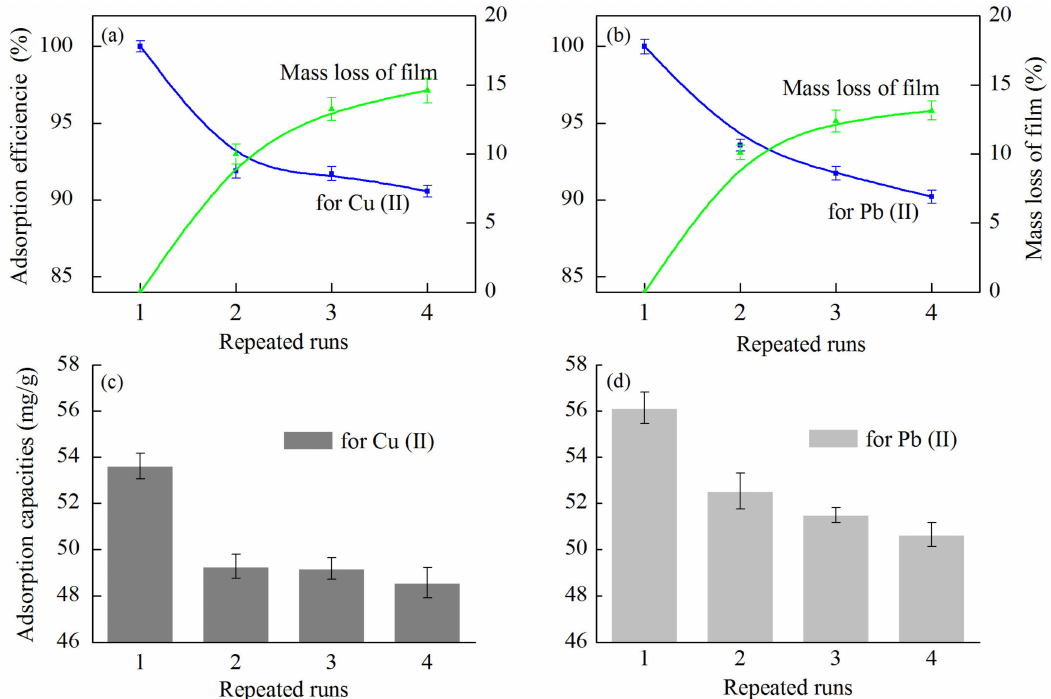
Figure 10. The adsorption efficiency and the stability of the CNC/CS/PVA-SH nanofibrous films for ( a ) Cu(II) and ( b ) Pb(II) ion during repeated runs; The adsorption capacities of ( c ) Cu(II) and ( d ) Pb(II) ion on nanofibrous